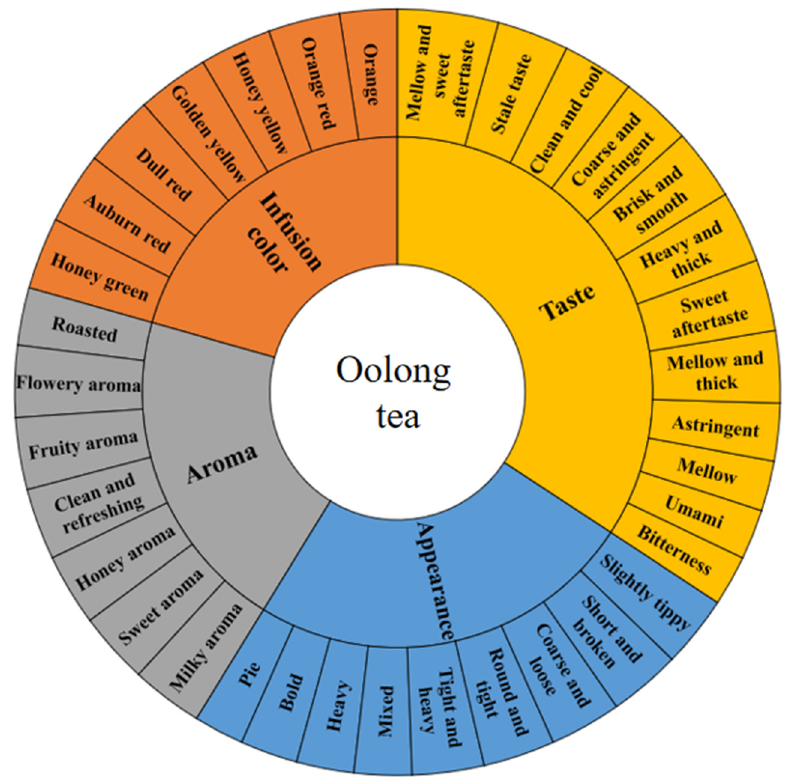
Figure 1. Flavor wheel of Oolong